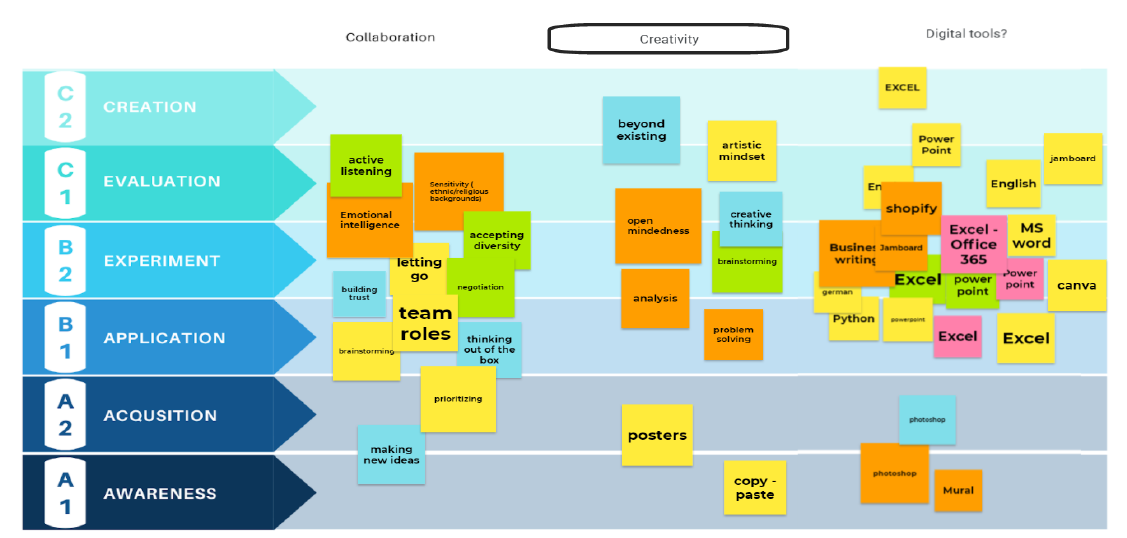
F IGURE 2. T HE COLLECTIVE SYNCHRONOUS SELF - EVALUATION OF THE C OLLABORATION , C REATIVITY AND D IGITAL T OOLS /C OLLABORATION BY THE E MPLOYABILITY II STUDENTS AT U NIVERSITY OF E UROPE ,